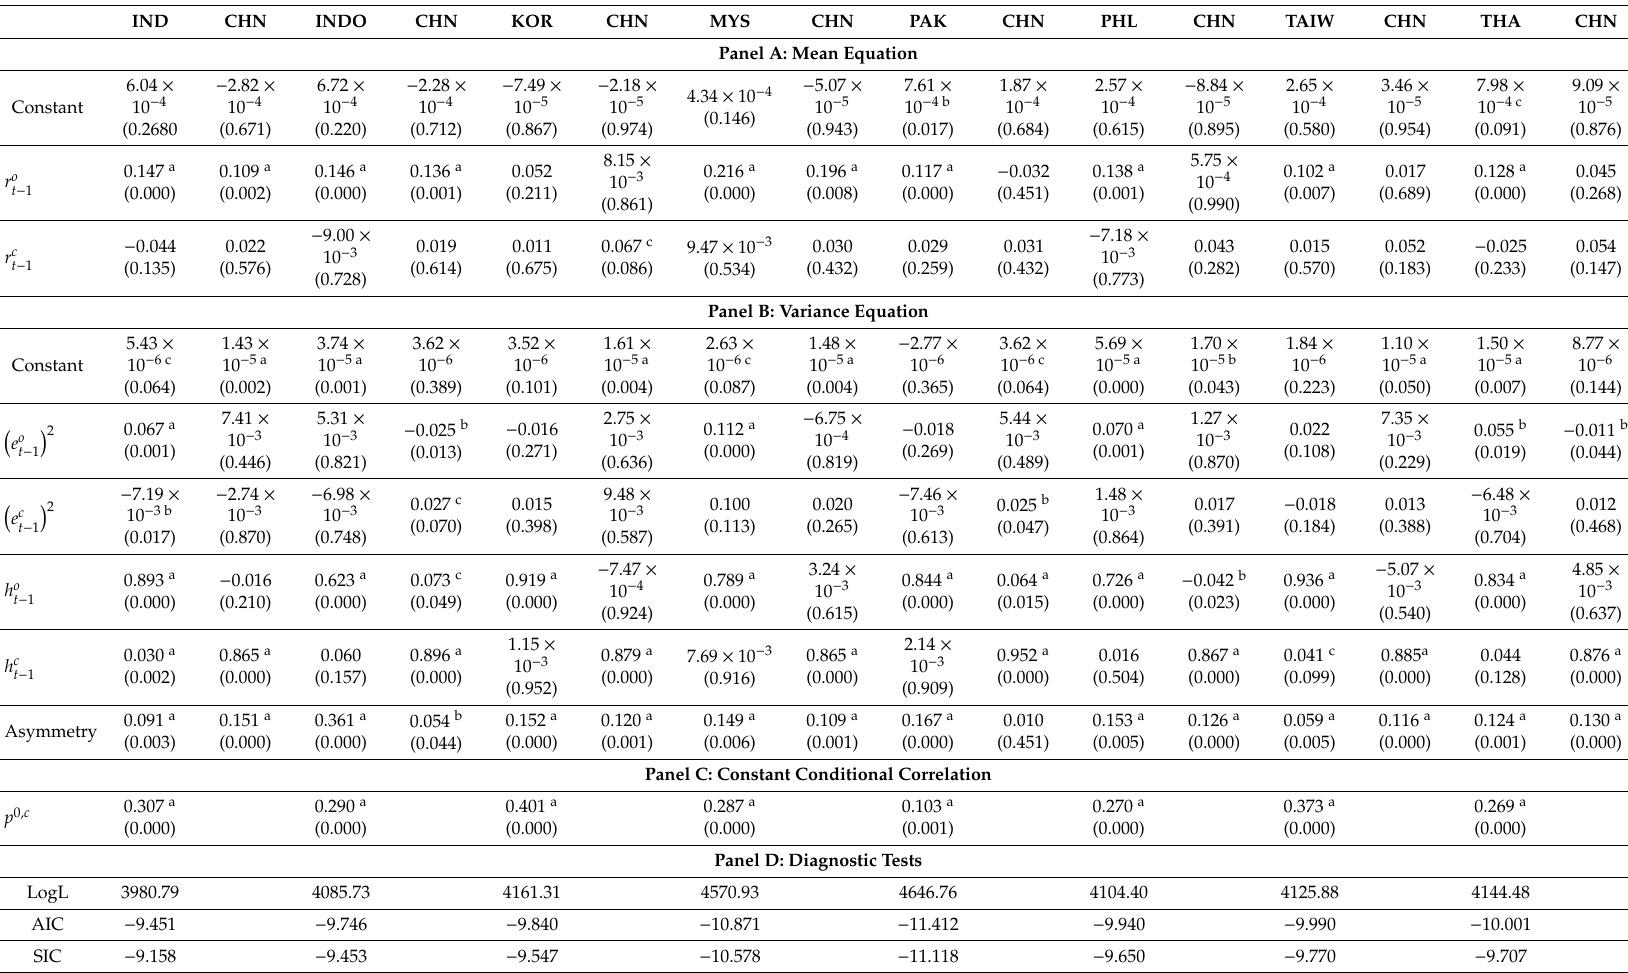
Table 5. Estimates of bivariate VAR − AGARCH for China and Asian stock markets during the US Financial